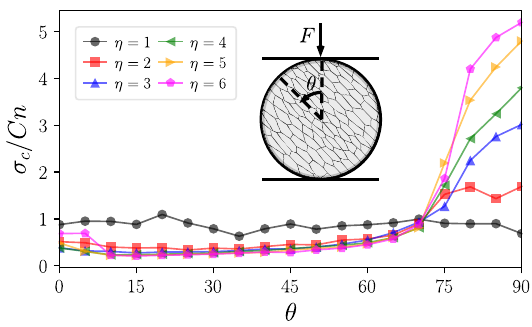
Figure 2. Failure strength as a function of the level of inherent anisotropy ⌘ and the loading orientation ✓ . In the inset: schematic representation of our loading procedure and the relative loading orientation relative to the rock